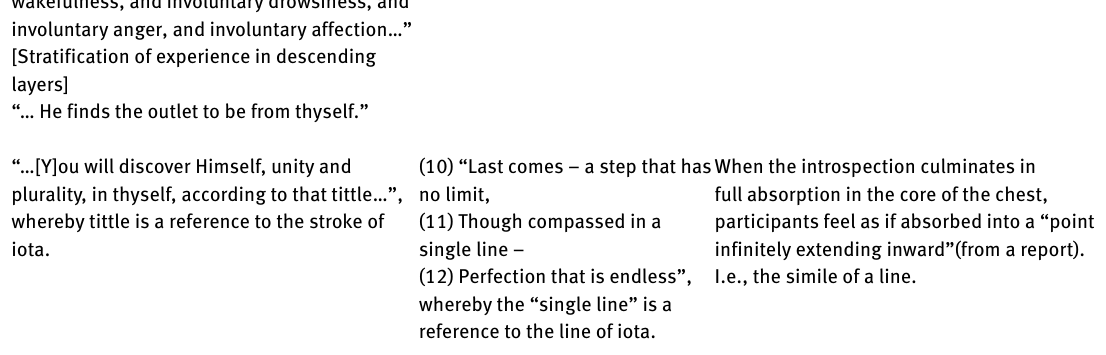
Correlation with experience in live subjects poem General introspective orientation Turning attention inward, onto and into the of the traditional Prayer of the egological somatic Heart.